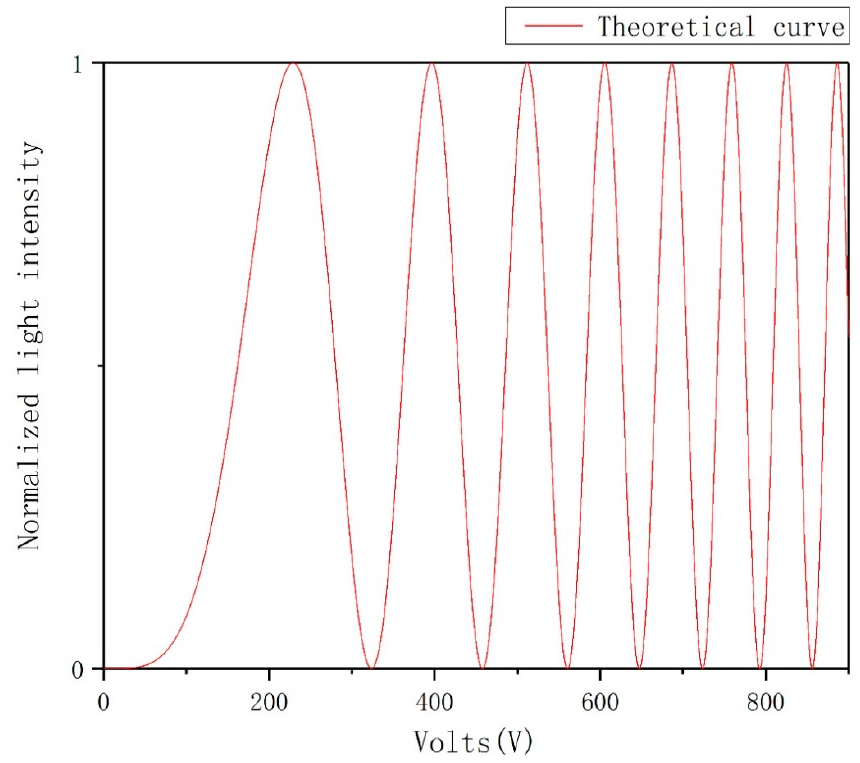
Figure 3. Theoretical curve calculated and simulated by the effective electro-optic coefficient.